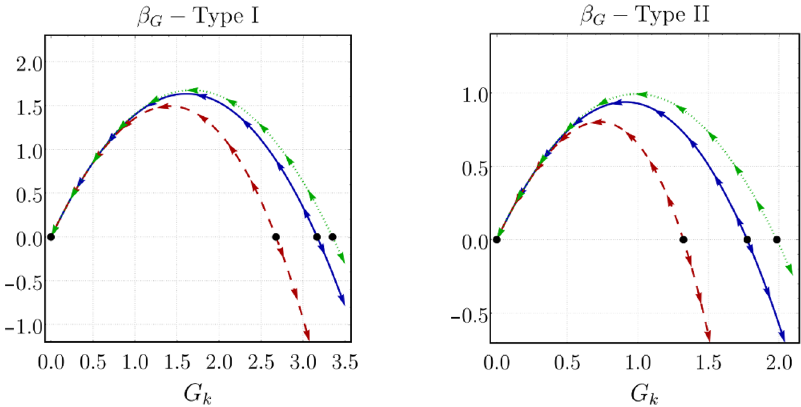
Figure 5 . Beta function for the dimensionless Newton’s coupling in the case ~ m 2 plot on the left (right) correspond to the type I (II) coarse-graining operator. The blue (continuous) line corresponds to the case where the anomalous dimensions were replaced by the results reported in the appendix B. The red (dashed) and green (dotted) lines represent \RG improved" and 1-loop closure, respectively. Conventionally, the arrows point towards the infrared.